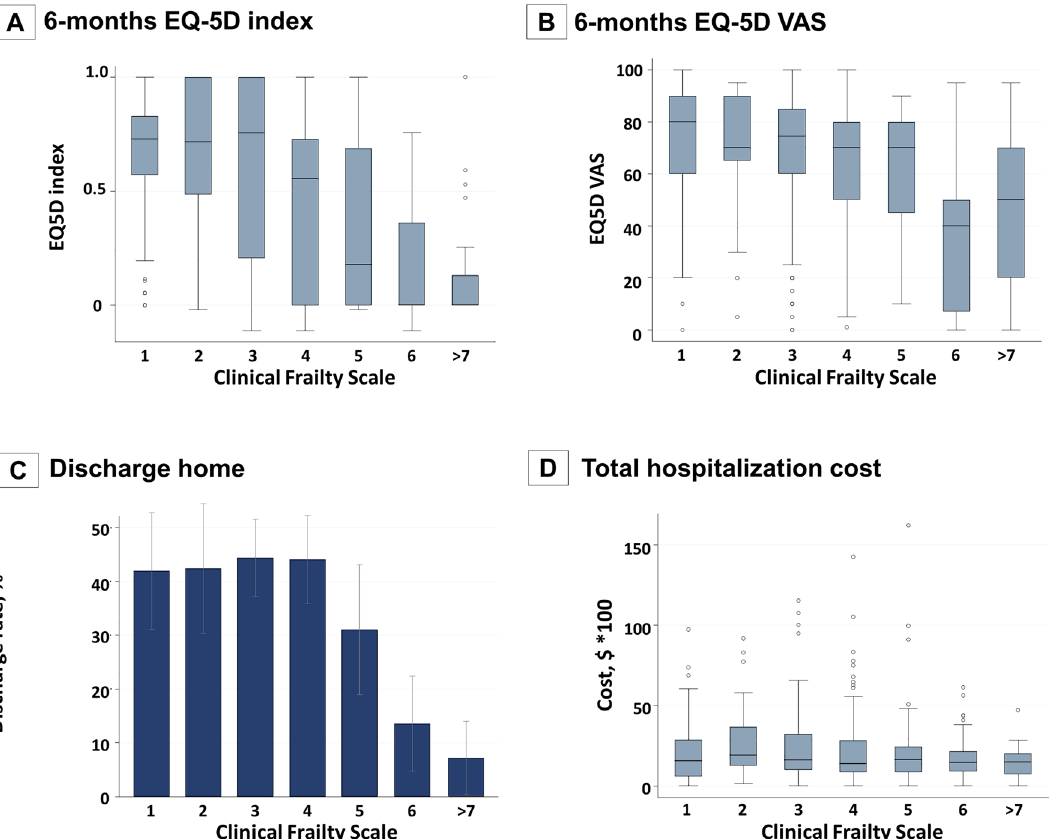
Figure 3. Association between each Clinical Frailty Scale score and secondary outcomes. ( A ) Quality of life as indicated by the EuroQol 5 Dimensions (EQ5D) index. ( B ) Quality of life as indicated by the EQ-5D using a Visual Analog Scale (VAS). ( C ) Discharge home. Home was defined as home of the patient or a relative (other than hospitals or nursing homes). ( D ) Total hospitalization cost. The actual cost of hospitalization on a piece- rate basis. Converted from Yen to US